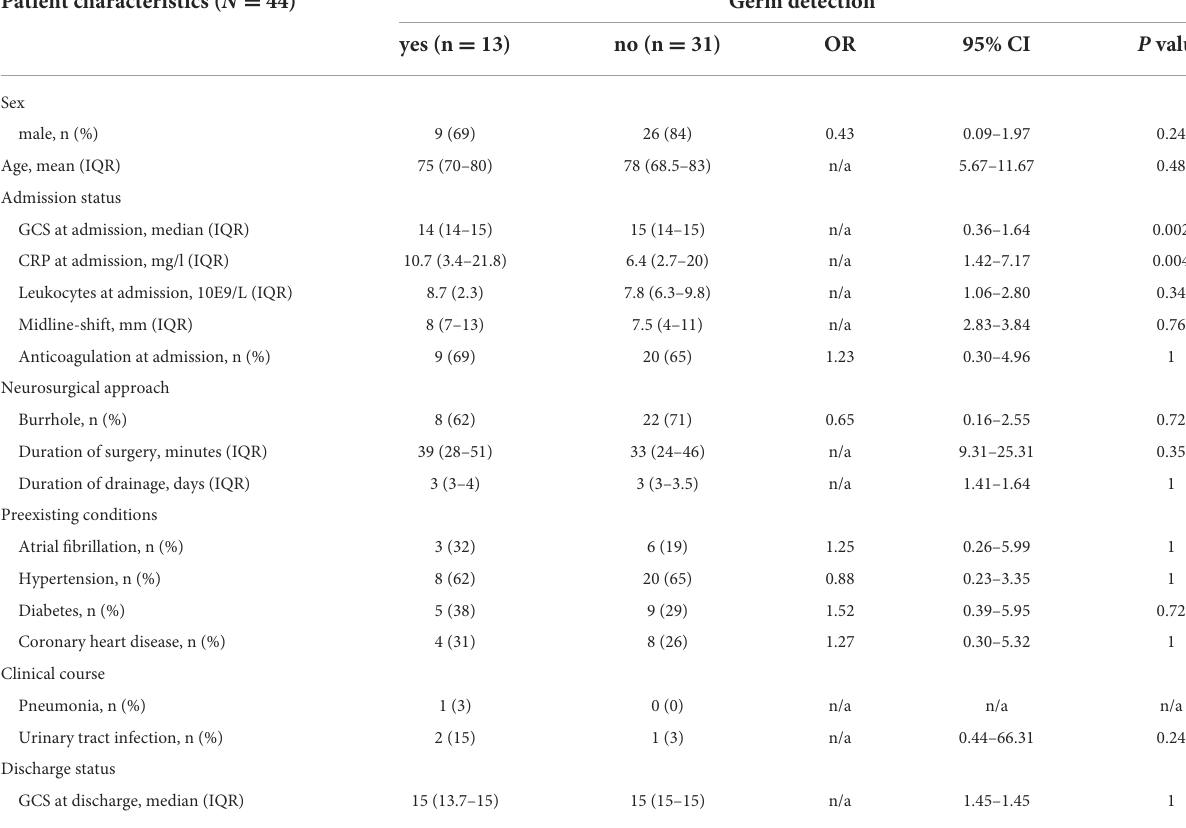
TABLE 2 Analysis of juxtaposed characteristics according to inapparent germ detection in chronic subdural hematoma